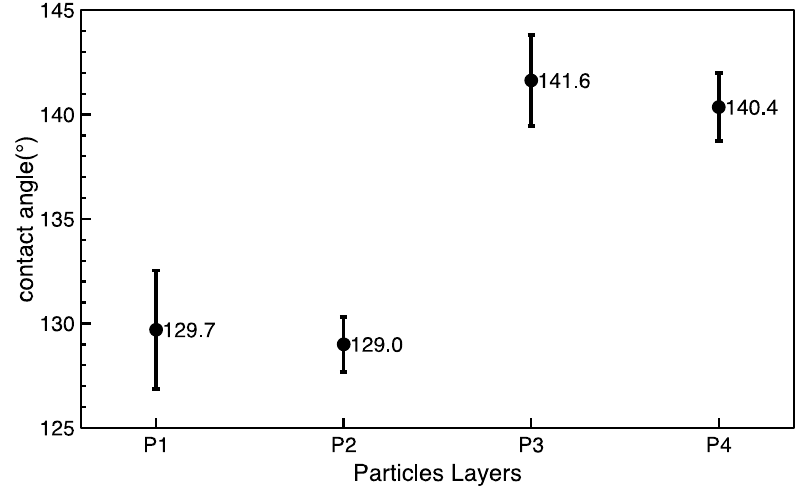
Figure 8. Contact angles after 6 minutes of washing of as-prepared PTFE layers.